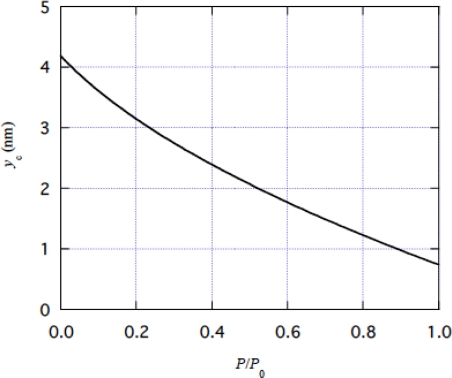
yc as a function of P/P0, calculate by Eq. 4-1-3.